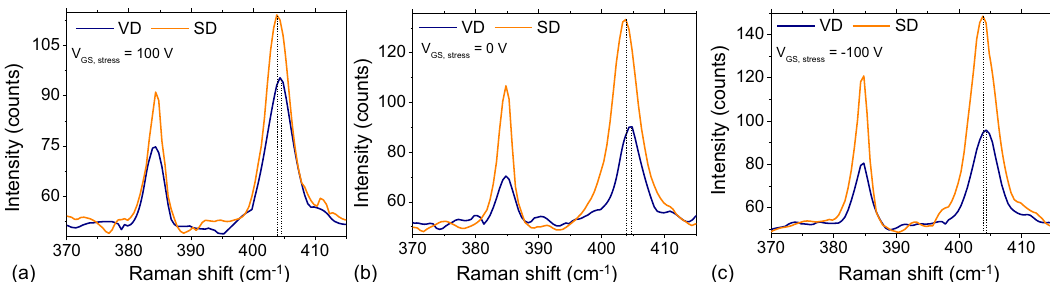
= 9 V. Along with red shift in A DS 1g mode, substantial increase in the Raman